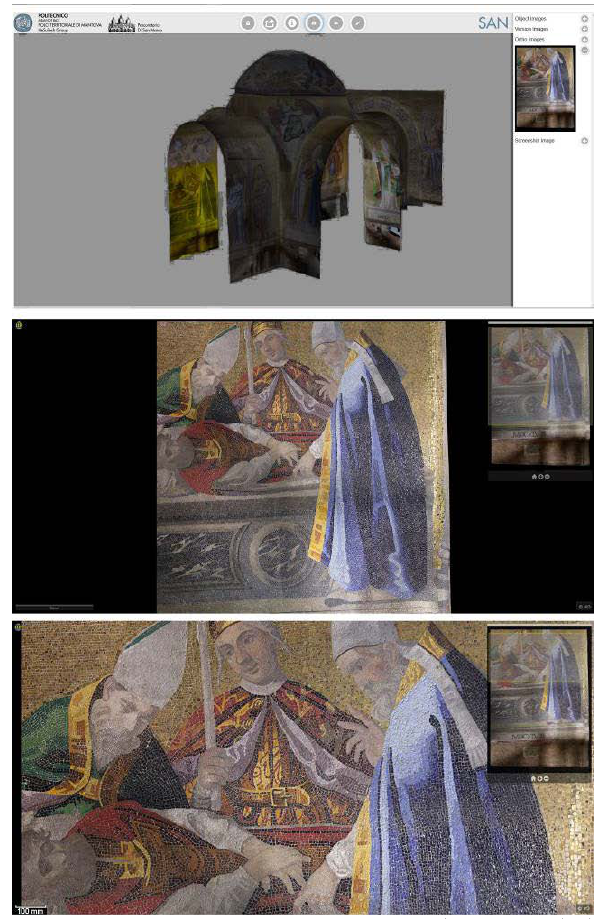
Figure 8: The orthophoto fruition by the user (from the top): i) selection of the element and choice of the orthophoto to be viewed, ii)orthophoto visualization with navigation tools, iii) visualization of details of the orthophoto at the maximum zoom, with scale bar and navigation